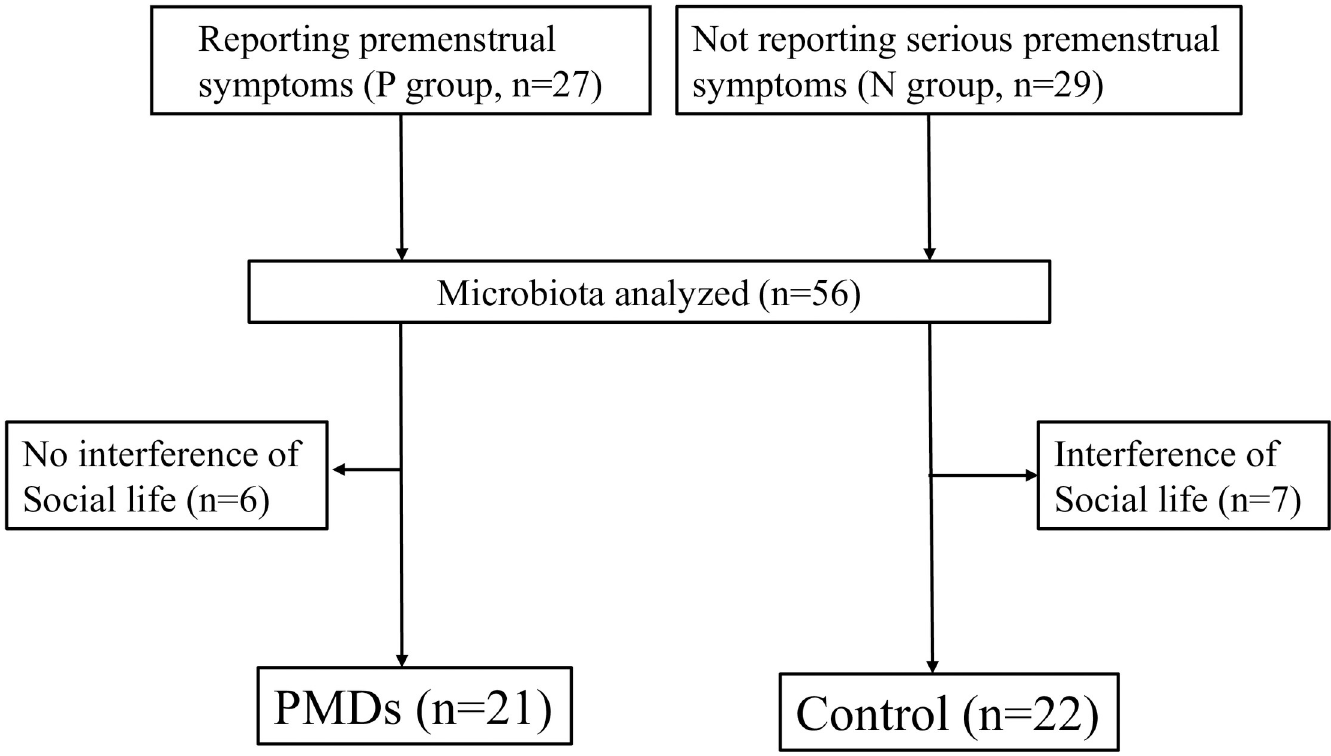
Fig 1. Flow chart of the study design. Abbreviation: PMDs, premenstrual